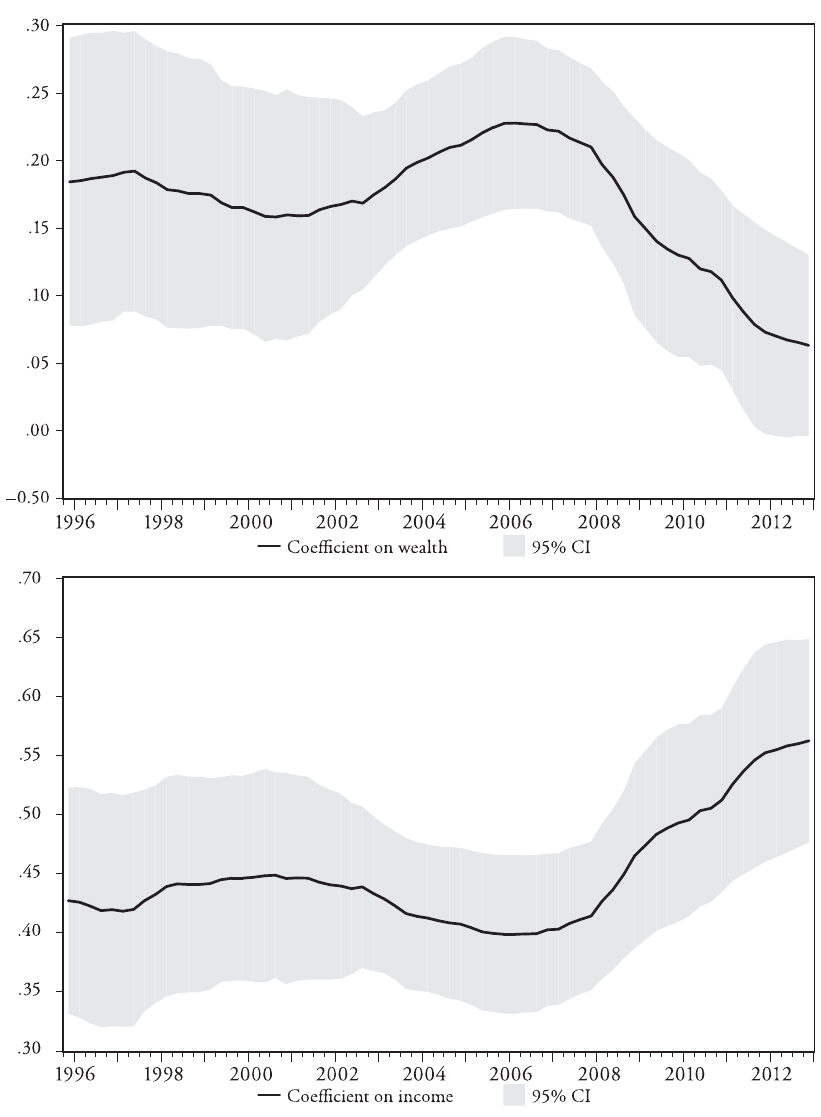
Figure 9: Recunivc Estimation Results for the Cointegration